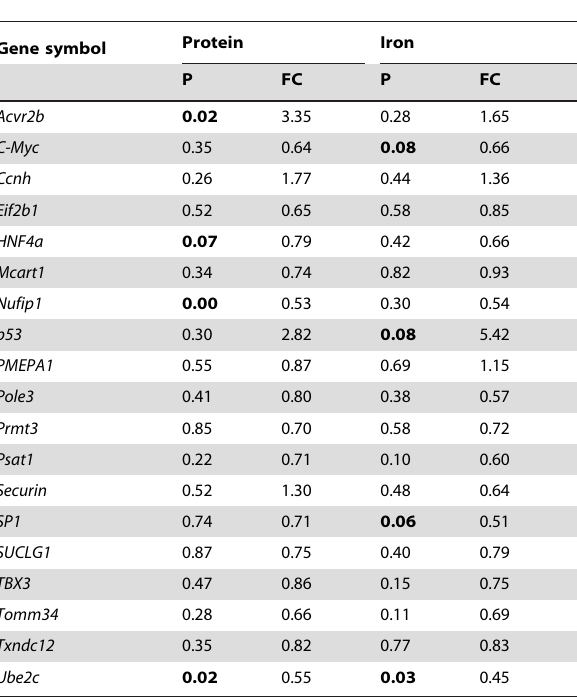
Table 4. Expression of selection of microarray genes in embryonic tissue analysed by real-time PCR in response to iron deficiency in Rowett Hooded Lister rats (FC =fold-